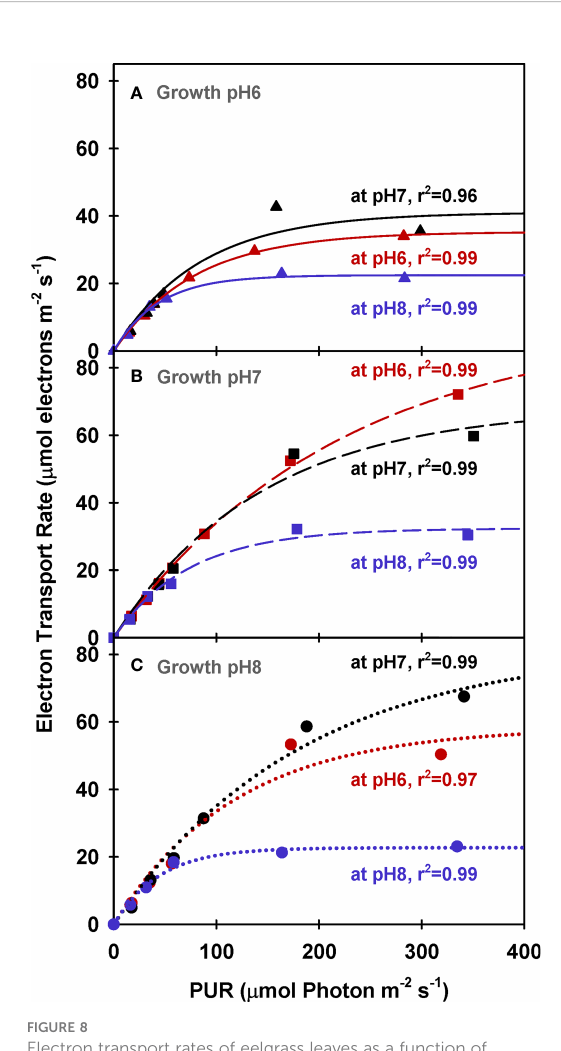
FIGURE 9 Modeled gross photosynthesis of eelgrass leaves as a function of absorbed irradiance for plants growing at pH6 (2121 m M CO 2(aq) ) (A) , pH7 (371 m M CO 2(aq) ) (B) and ambient pH8 (55 m M CO 2(aq) ) (C) . Solid lines are calculated from leaf area normalized O 2 production rates (Equation 1) and dashed lines are estimated from ETR measurements (Equation 12). Colors represent incubation pH/CO 2 levels. Green dot-dashed lines represent the theoretical O 2 production per absorbed photon under non- limiting environmental